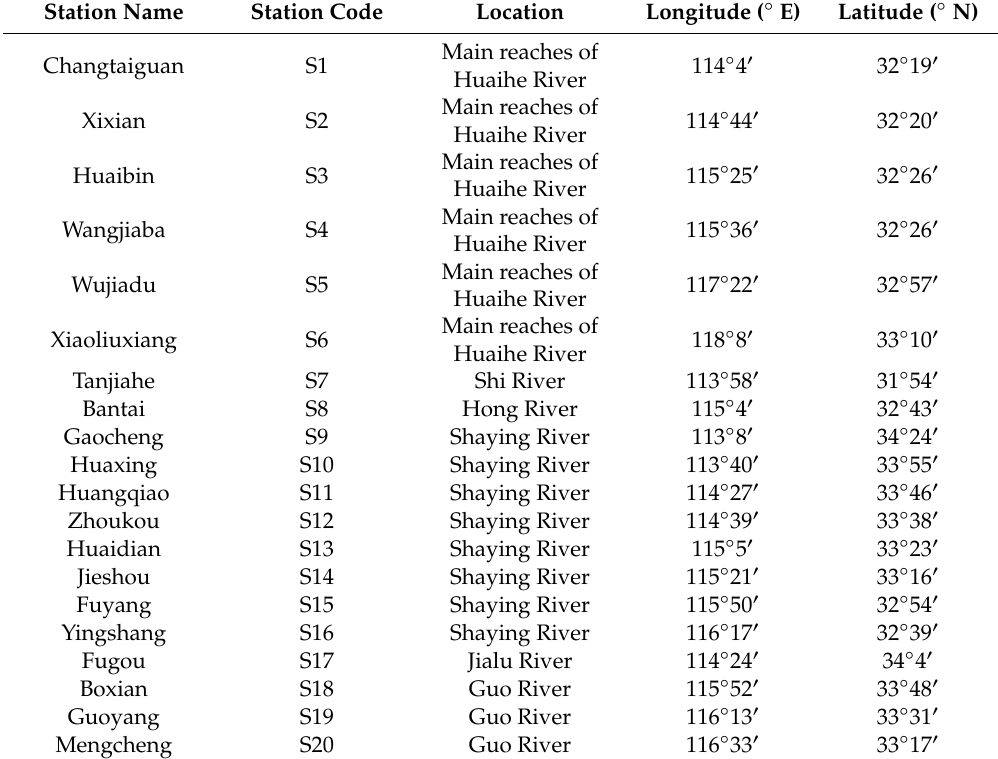
Table 1. The summary of twenty monitor stations in the